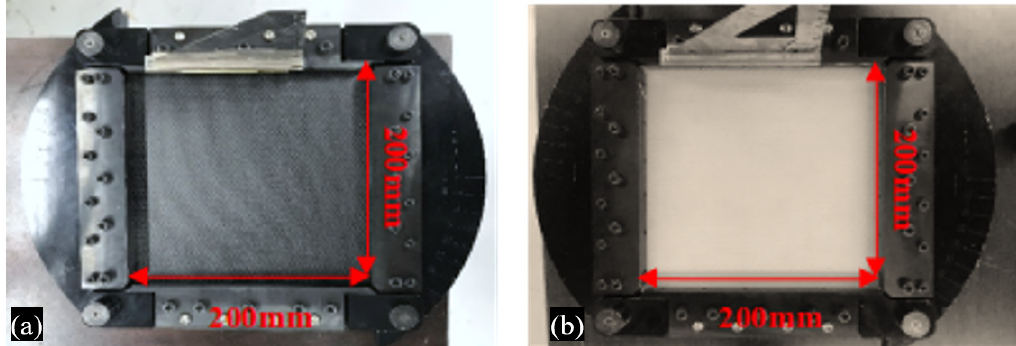
Figure 6. Specimens in the clamping apparatus: ( a ) carbon specimen and ( b ) glass specimen.